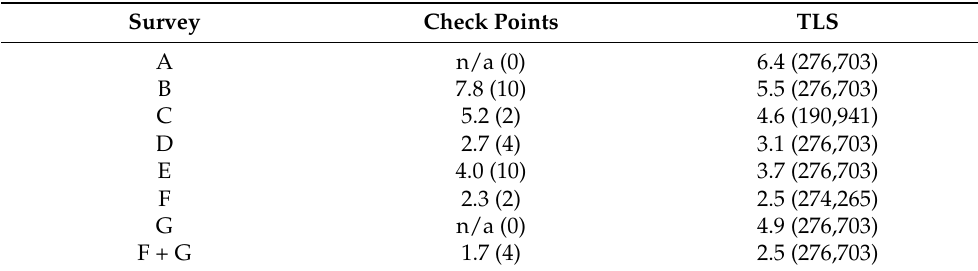
Table 4. Comparison of the final 3D precision (cm) for each SfM-UAV survey (A–G) obtained from two different independent reference data resources (check points and TLS). The number of points used in each comparison is stated in brackets.